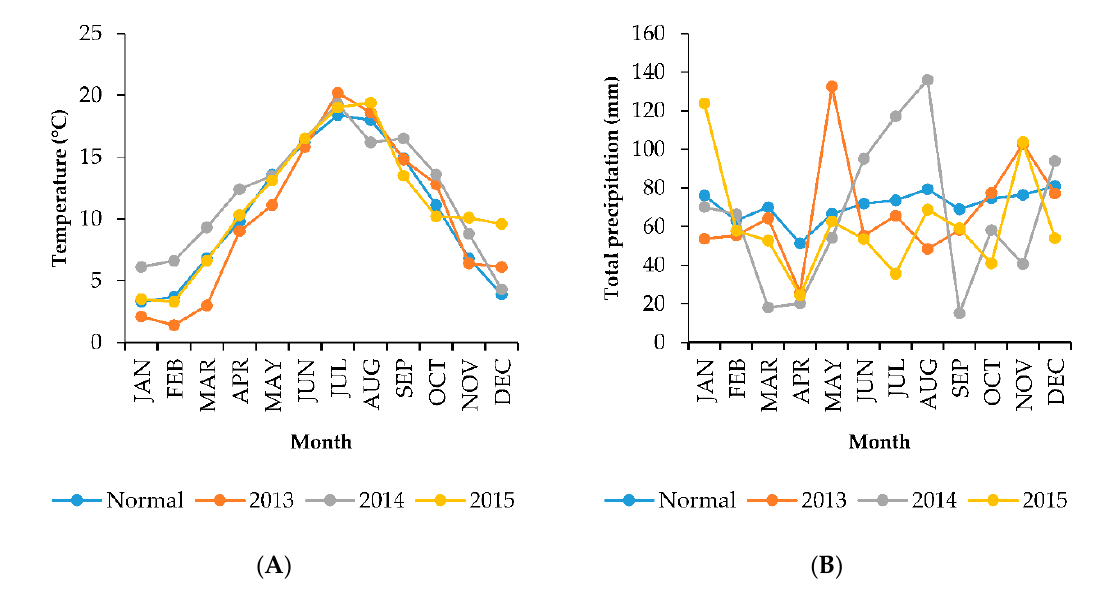
Figure A4. Meteorological data measured in Ukkel in 2013, 2014 and 2015. ( A ) Mean monthly temperature; ( B ) Total monthly precipitation [47] .